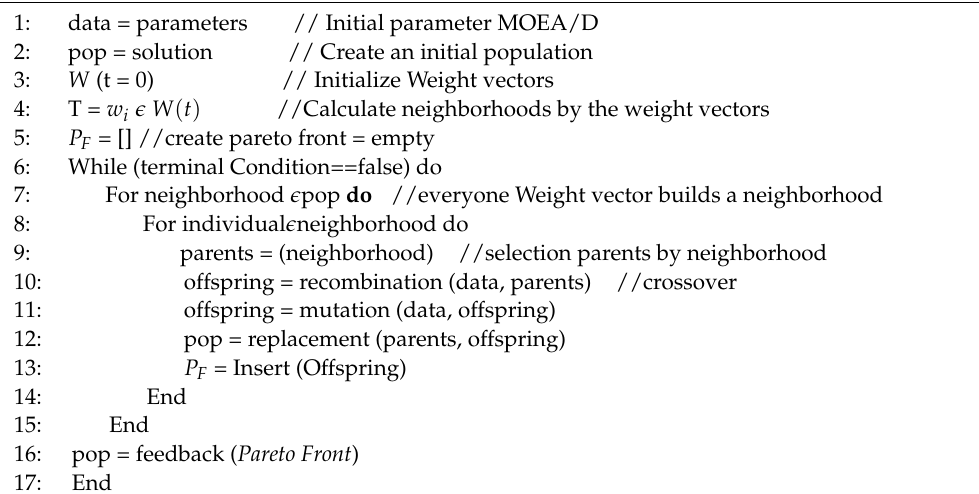
Algorithm 3. Pseudocode of metaheuristics based on